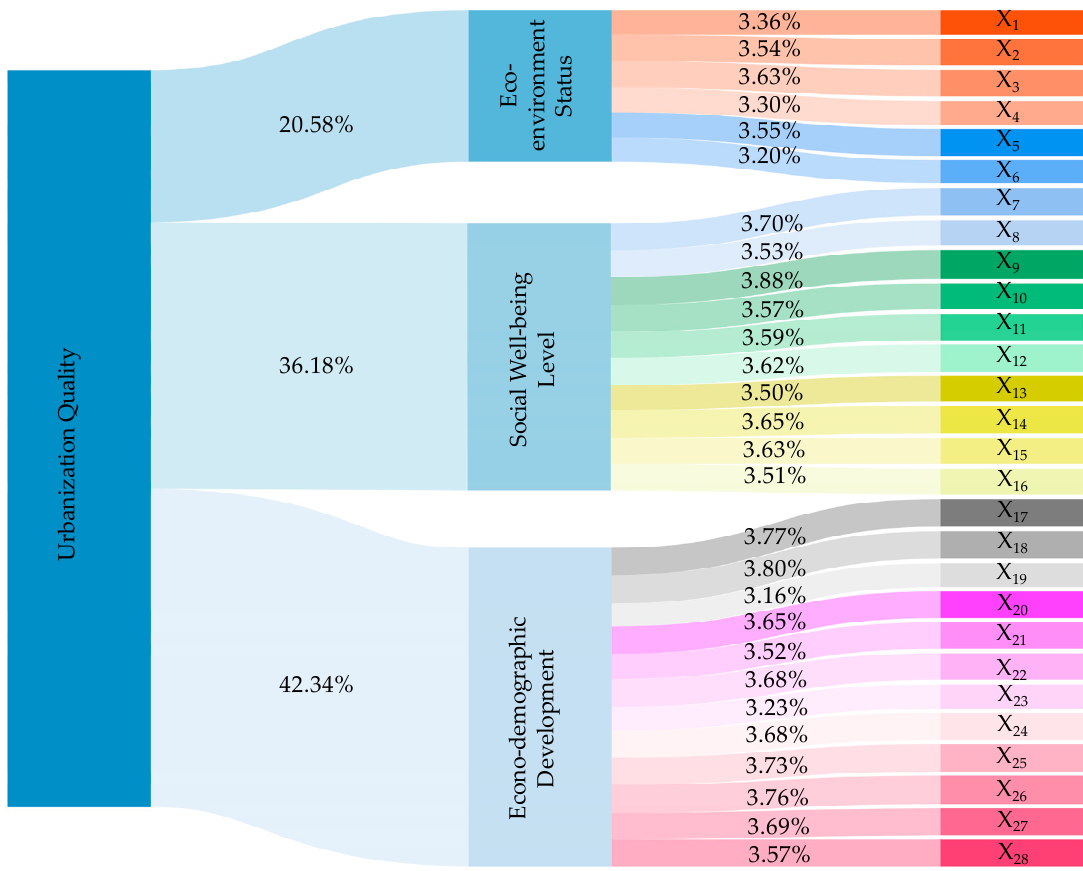
Figure 6. Weight of each indicator for the urbanization quality evaluation system ((X 1 : Per capita